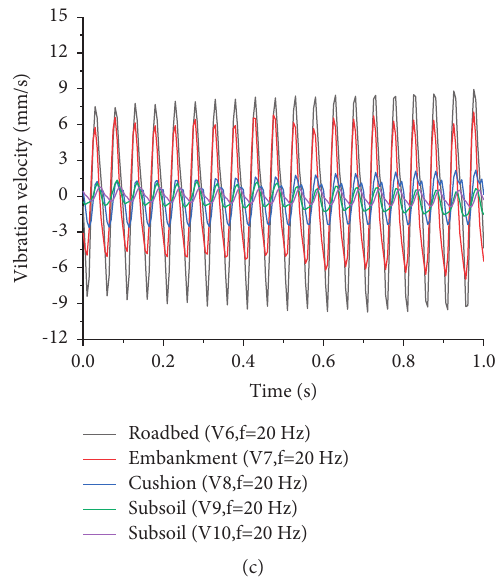
Figure 9: Time histories of vibration velocity at embankment, cushion, and subsoil for three cyclic loading frequencies. (a) f � 5 Hz. (b) f � 10Hz. (c) f � 20Hz.